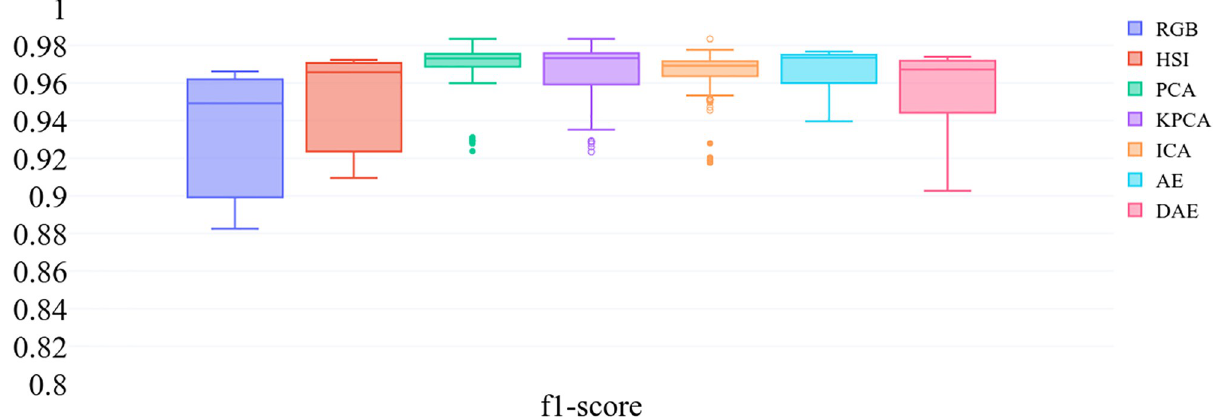
Fig 6. F1-scores across all compression rates for all datasets and landcover types using PCA, KPCA, ICA AE and DAE methods. This figure also includes precision, recall and f1 score for all datasets and landcover types when using RGB data for pixel classification.